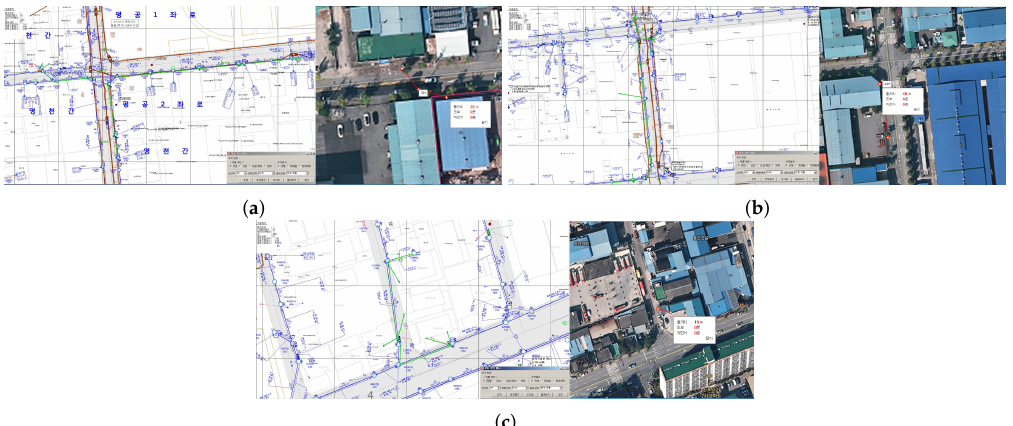
Figure 17. NDIS maps for the Overhead Factory Area. ( a ) Site 4-1. ( b ) Site 4-2. ( c ) Site 4-3.